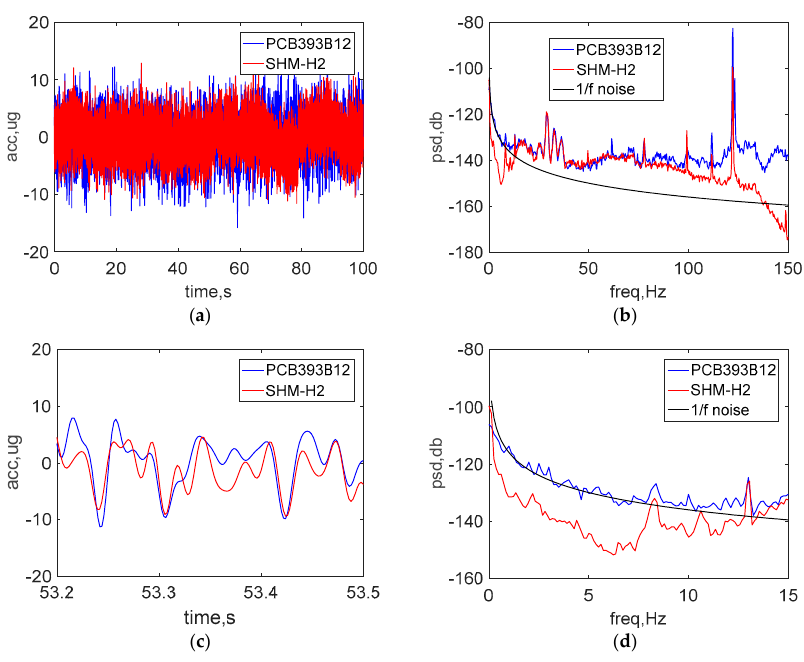
Figure 13. Test results on country road: ( a ) time history data ( b ) PSD data ( c ) zoomed view of time history data ( d ) zoomed view of low-frequency PSD data.